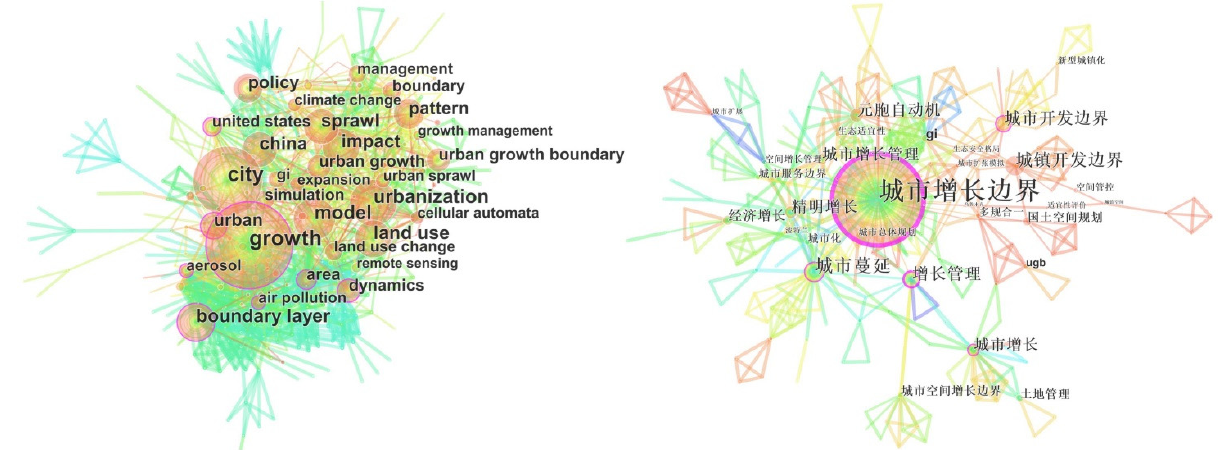
Figure 2. Co-occurrence map of high-frequency keywords in foreign languages ( left ) and Chinese ( right ) for urban growth boundary research, 1998–2019. (Please refer to Appendix A Table A1 for the translation of Chinese words).